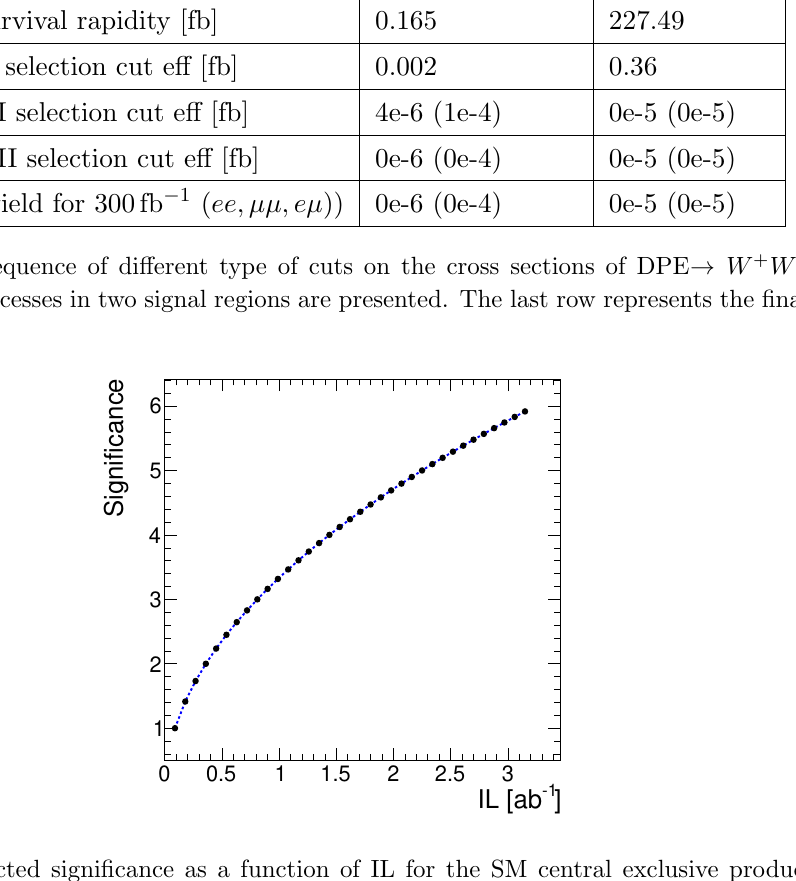
Figure 8 . Expected signi(cid:12)cance as a function of IL for the SM central exclusive production of W + W (cid:0) (cid:13) process using only di-leptonic